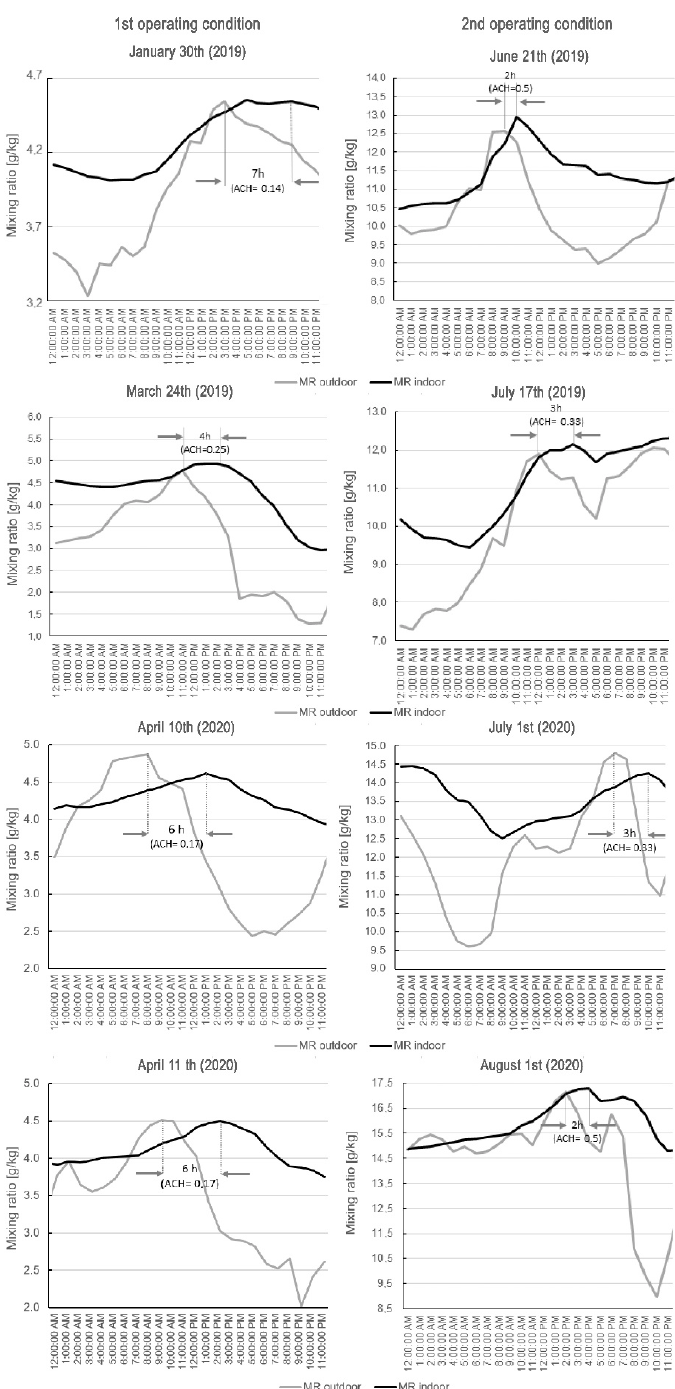
Figure 7. Estimation of time elapsed between peak outdoor (MR outdoor) and indoor (MR indoor) mixing ratio for some sample days of 2019 and 2020 for the first and the second operating